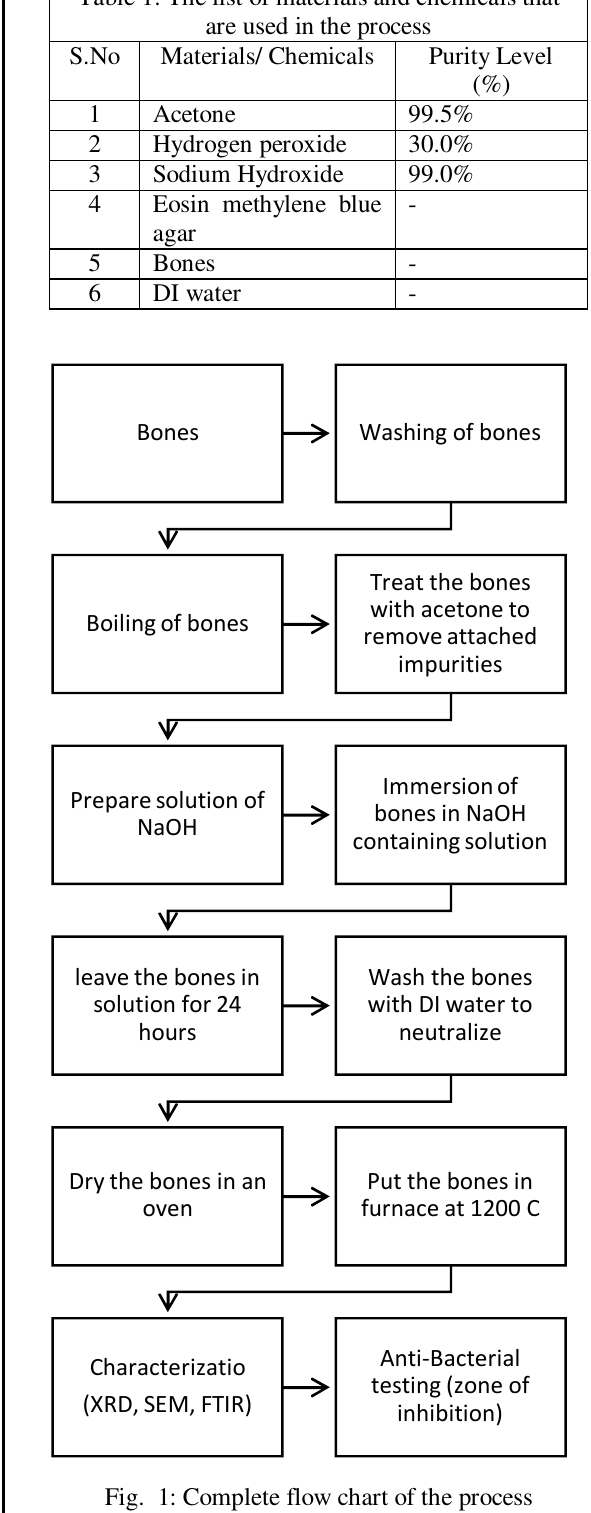
Fig. 1: Complete flow chart of the process